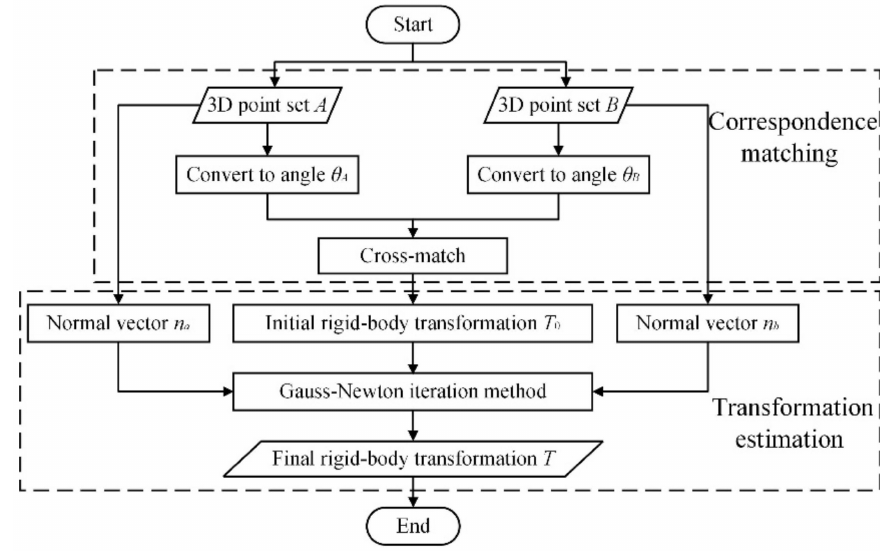
Figure 7. Flow chart of point-cloud